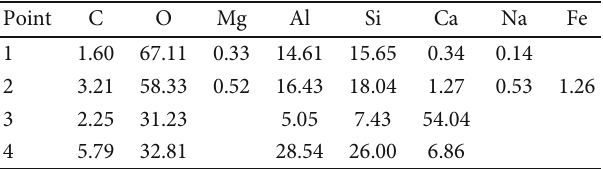
Table 7: Analysis atomic percentage of elements at di ff erent points.